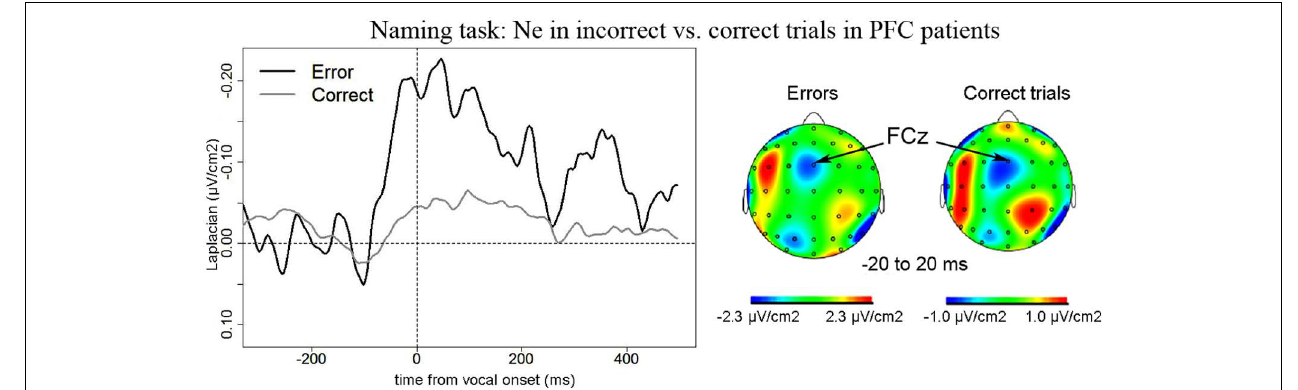
FIGURE 2 | EEG activity in PFC patients in the Naming task after surface Laplacian transformation, recorded at FCz for errors (black line) and correct trials (gray line). Zero of time represents vocal onset.The cartographies were made on a 40-ms time-window centered on vocal onset